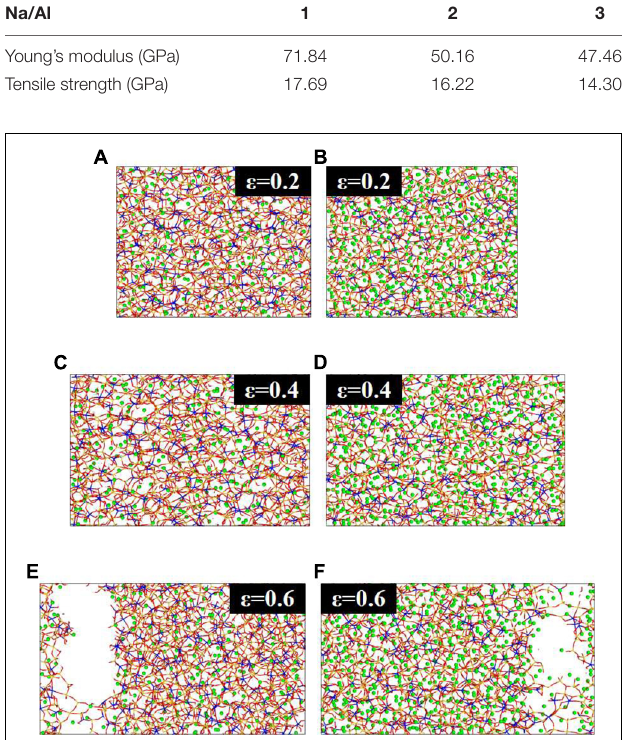
trends, the intrinsic strength and failure strain of the specimen with a different Na/Al ratio is obviously different from others.